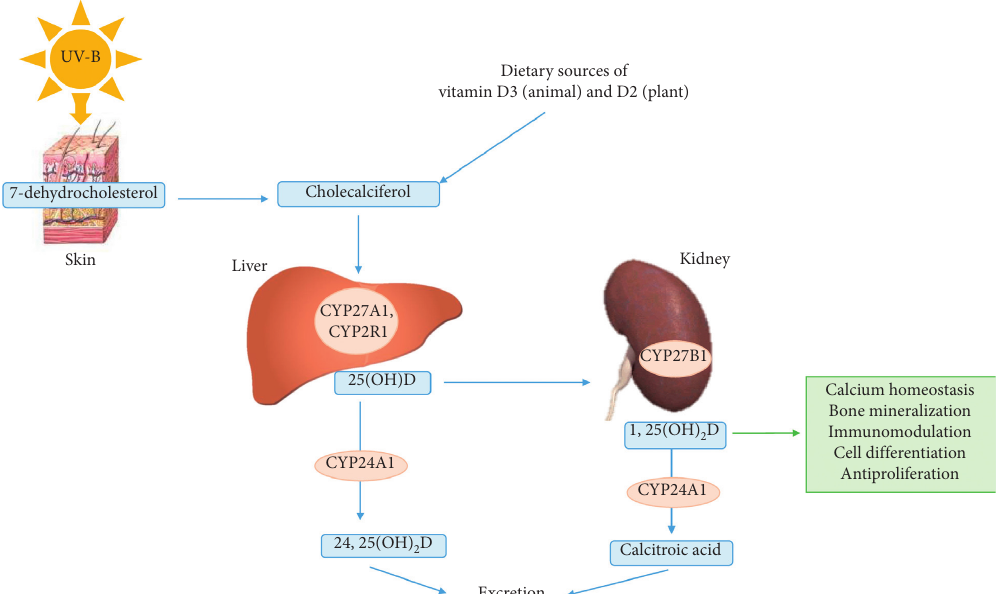
Figure 1: Normal vitamin D metabolism. Vitamin D can either be produced in the skin from 7-dehydrocholesterol under the influence of UV light, so-called vitamin D3 (cholecalciferol), or from ergosterol or directly absorbed from the diet as vitamin D3 and vitamin D2 (ergocalciferol). Either form is then hydroxylated to 25-hydroxycholecalciferol (calcidiol or calcifediol, 25(OH)D) in the liver by the cytochrome P450 (CYP) 27A1. It is then transformed mainly in the kidney by 25-hydroxyvitamin D3-1 α -hydroxylase (CYP27B1) into 1 α ,25-dihydroxyvitamin D (1,25(OH) 2 D or calcitriol). Table 1: Vitamin D agents and half-lifes. Agent Half-life Vitamin D2